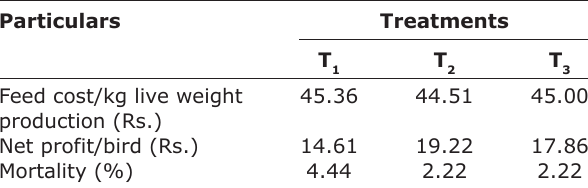
Table-4: Economics of broiler production and mortality in different treatment groups.